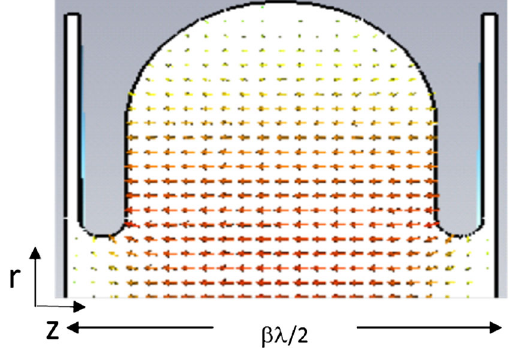
FIG. 1. A single cell in a bi-periodic standing wave cavity, with the electric